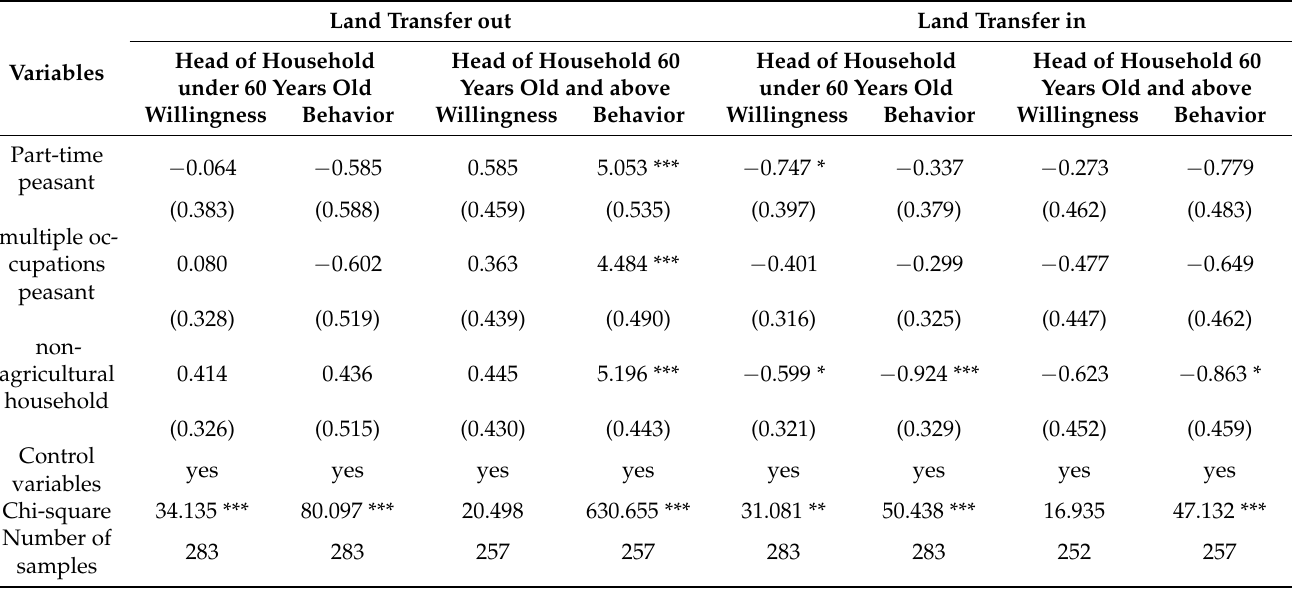
Table 7. Regression results of willingness and behavior of land transfer with different ages of household heads.